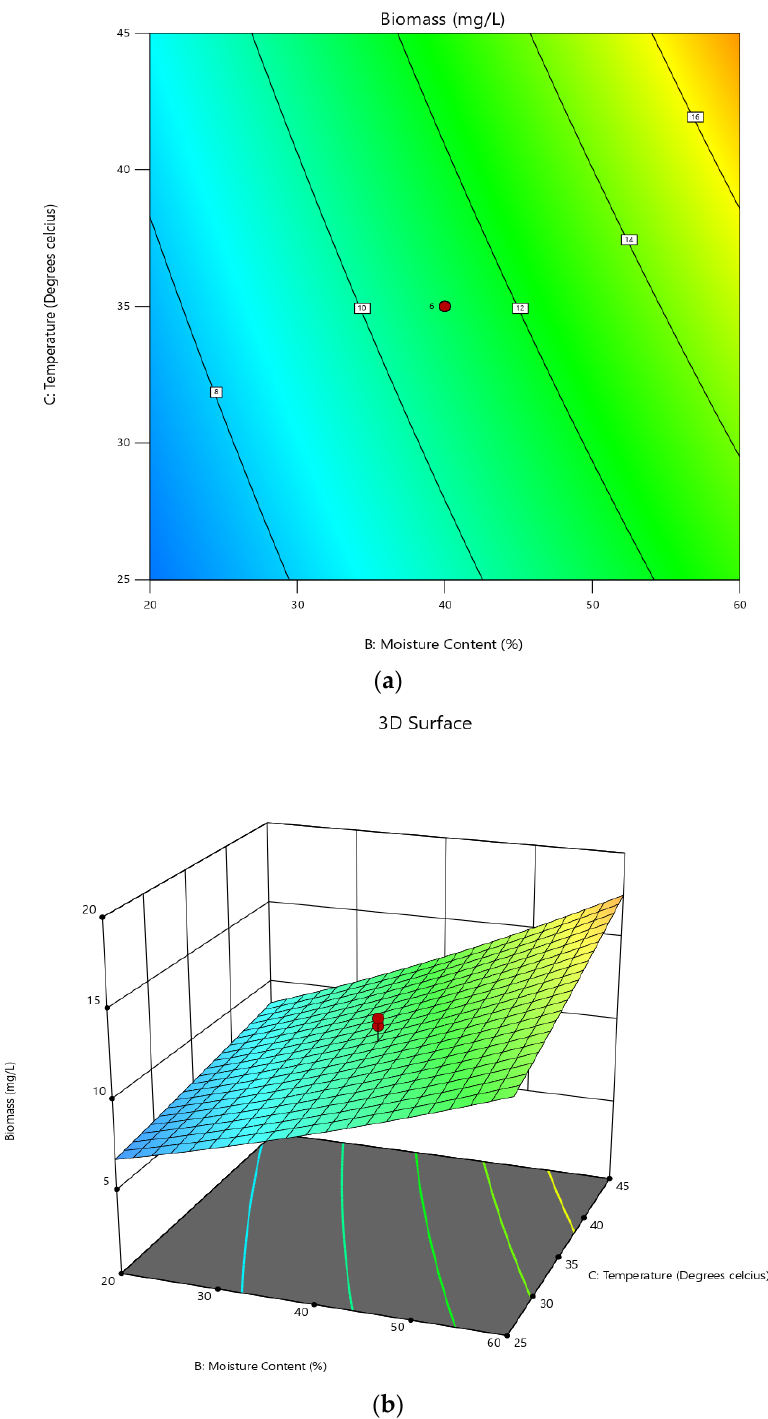
Figure 5. ( a ) Contour plot and ( b ) response surface plot of biomass as a function of temperature relative to moisture content.